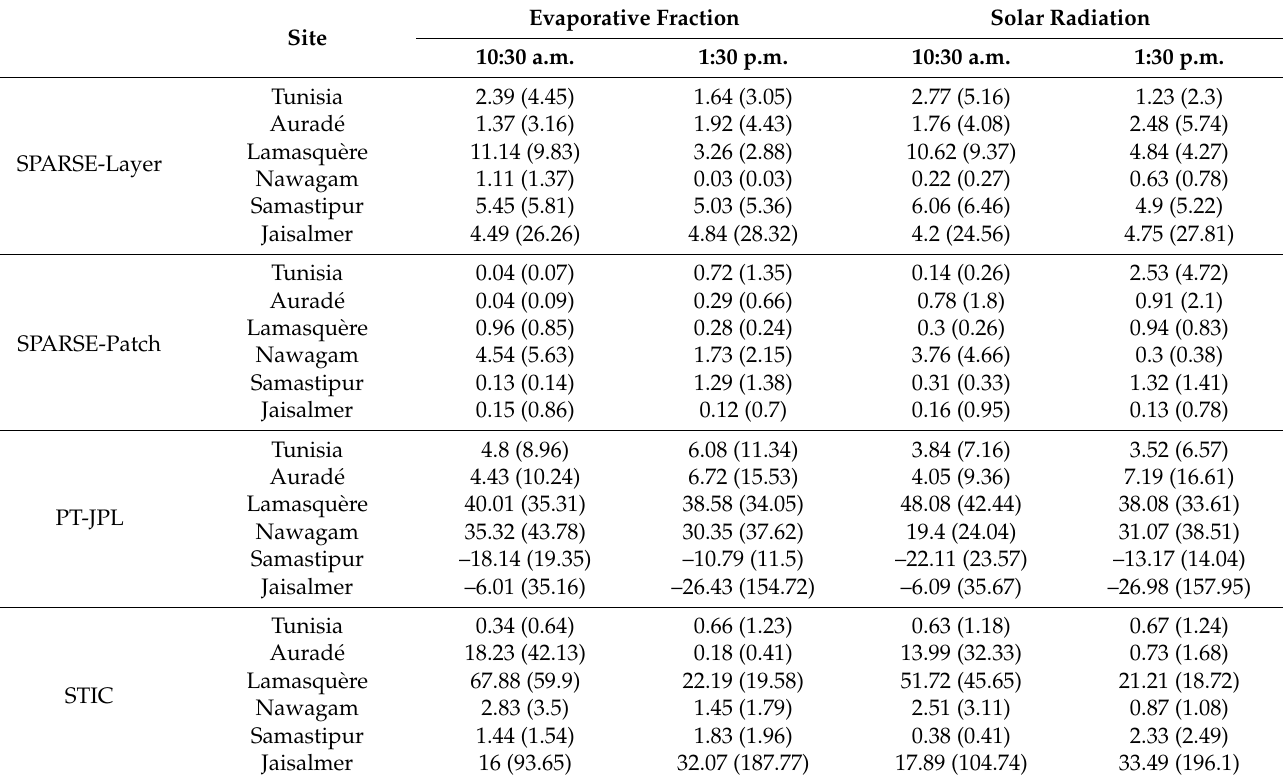
Table 2. The difference in RMSE between output and input aggregation (mm/month). Numbers in brackets express this RMSE difference as a percentage of in situ observed monthly ET. In the header, Evaporative Fraction and Solar Radiation indicate the scaling variable used to convert instantaneous ET (at 10:30 a.m. or 1:30 p.m.) to daily ET. Evaporative Site